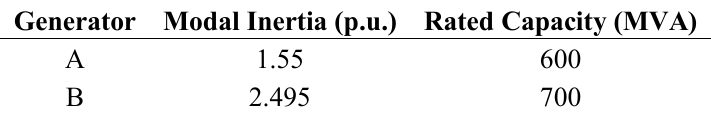
Table 3. Modal inertias of the generators under their common natural